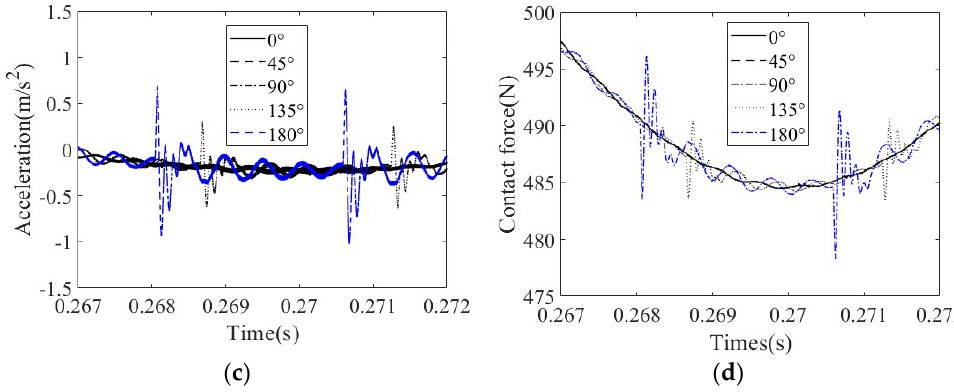
Figure 20. The vibration characteristics of the bearing under outer ring defect and defect location: ( a ) RMS and RMS y /RMS; ( b ) amplitudes of f r , f o − f c , f o , f o + f c , 2 f o − f c , 2 f o , 2 f o + f c ; ( c ) housing acceleration signal from 0.267 s to 0.272 s; ( d ) contact force between outer ring and housing from 0.267 s to 0.272 s.